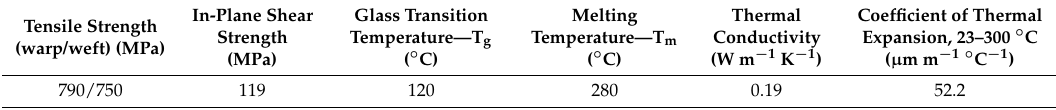
Table 3. Selected physical and mechanical properties of CF-PPS [22].